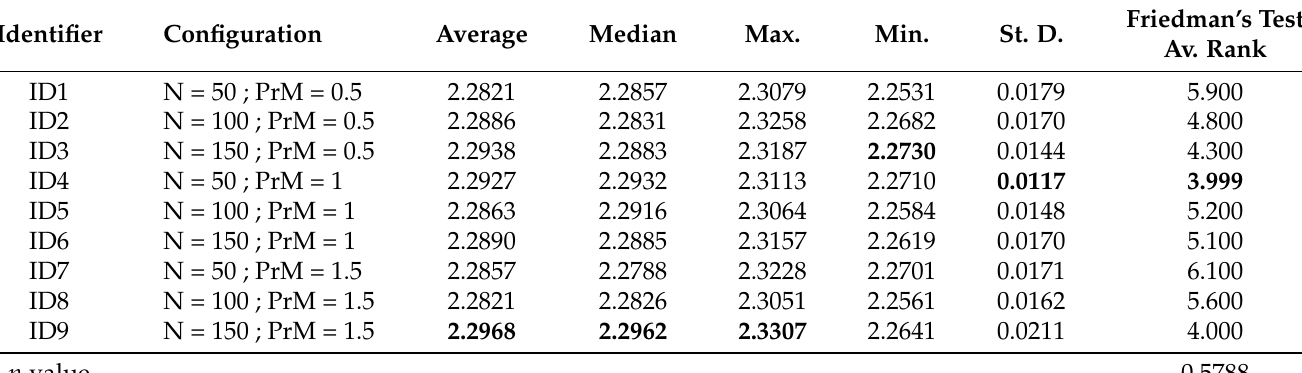
Table 4. Hypervolume statistics (Real